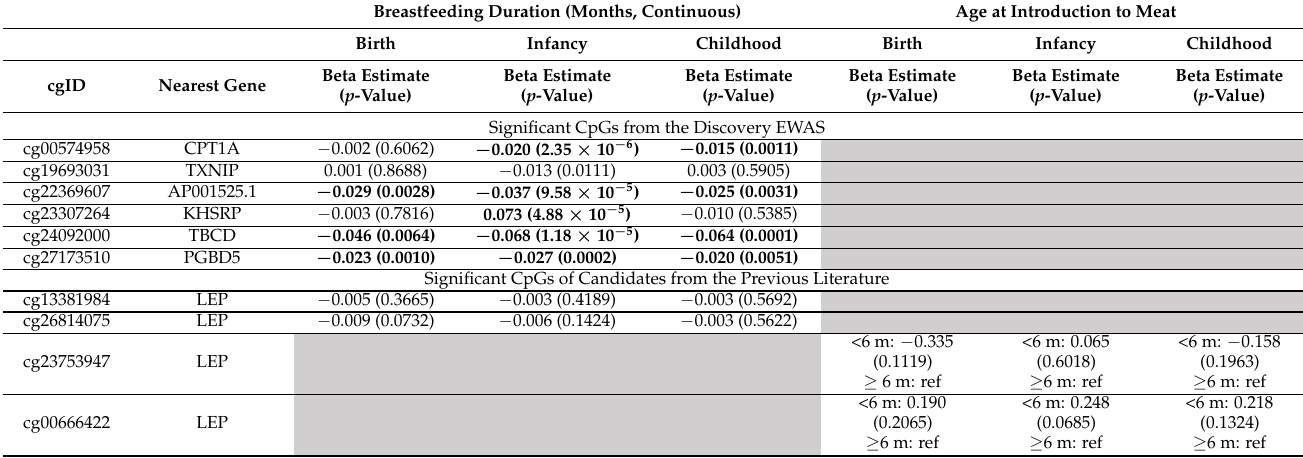
Models adjusted for age at methylation measure, sex, race/ethnicity, cell composition, and platform. Shaded grey cells indicate associations that were not tested because they were not significant in the EWAS nor candidate CpG analysis in infancy. Nominal p -values are presented in the table. Those less than the Bonferroni p -value cut-off of 0.0083 are indicated by